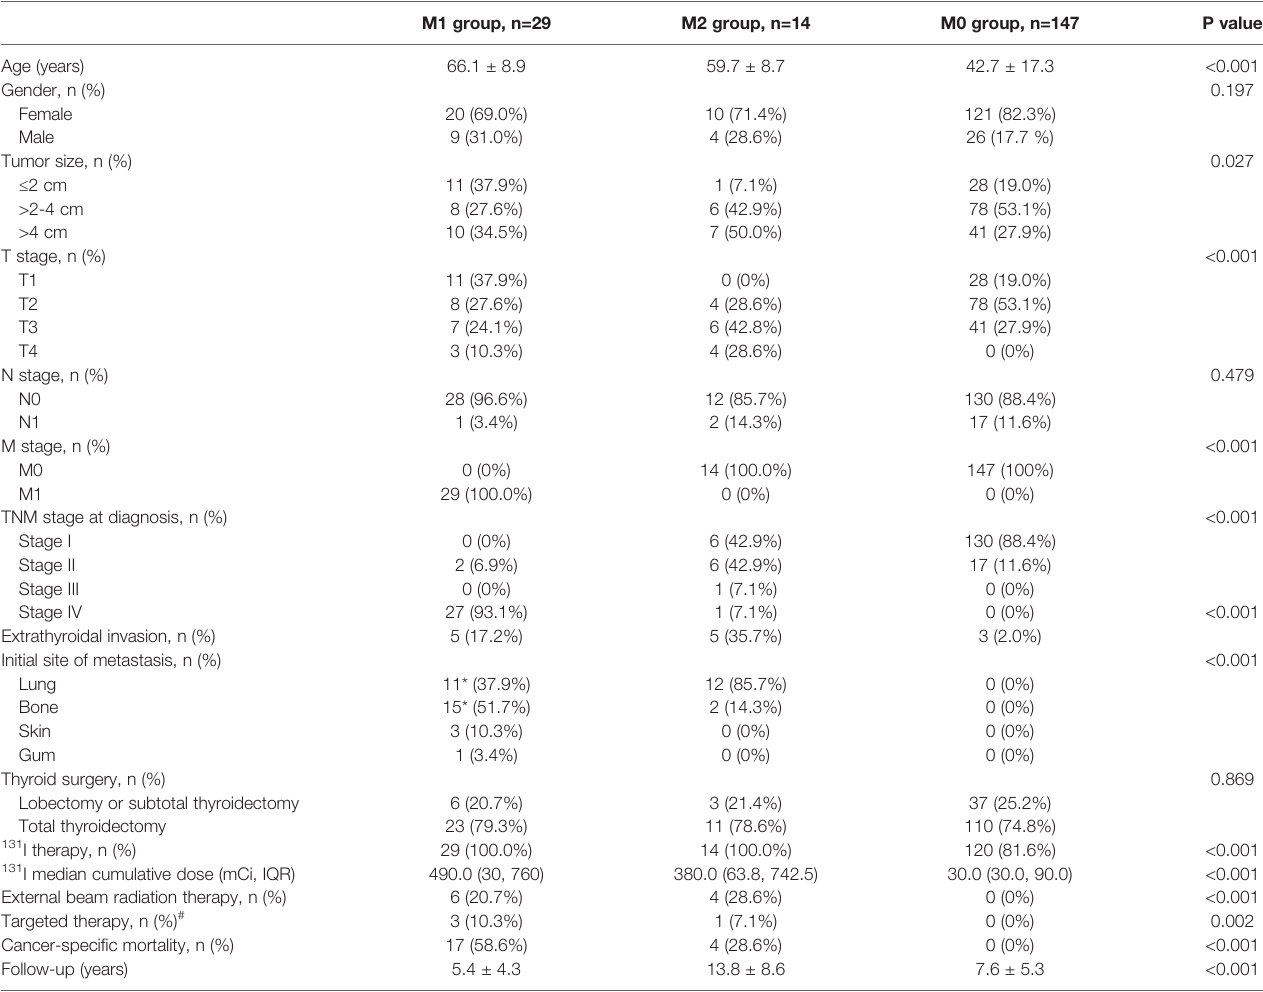
TABLE 1 | Clinical features of 190 patients with follicular thyroid